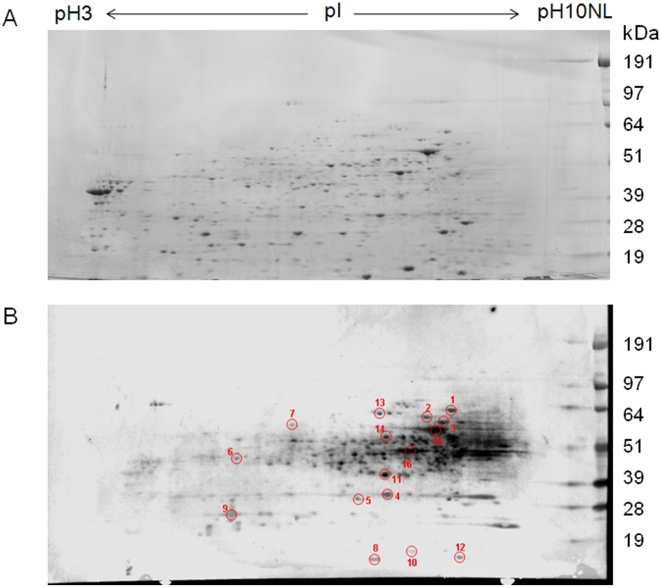

B. thailandensis whole cell lysate separated by two-dimensional gel electrophoresis.(A) SYPRO-ruby stained gel (B) Western blot performed using rabbit anti-B. mallei polyclonal sera (1∶200 dilution), followed by HRP-conjugated goat anti-rabbit IgG (1∶2000) and detected with Opti-4CN substrate (BioRad).